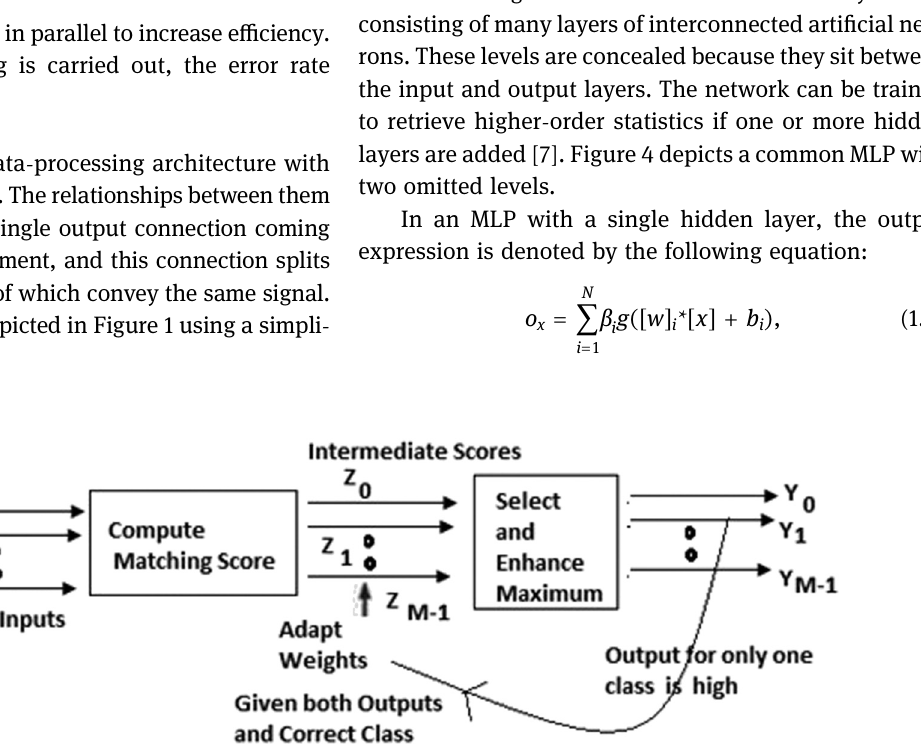
Figure 3: A typical ANN classi fi